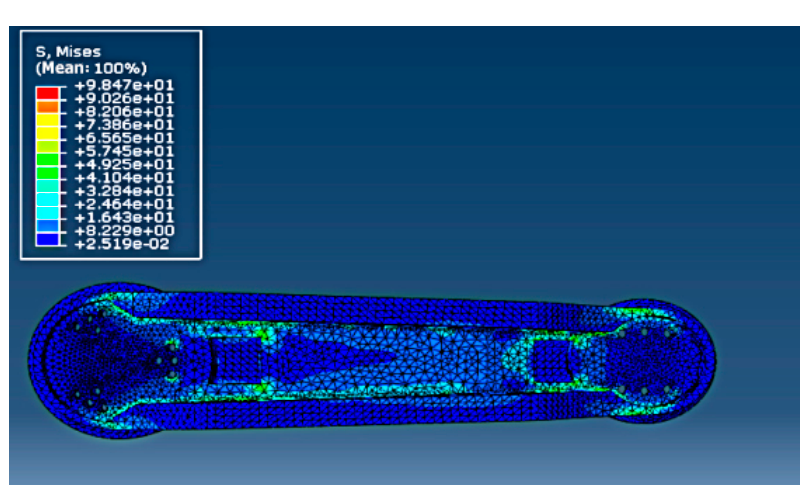
Figure 10. Mises stress cloud map in the most unfavorable working condition (dynamic loads) in ABAQUS.